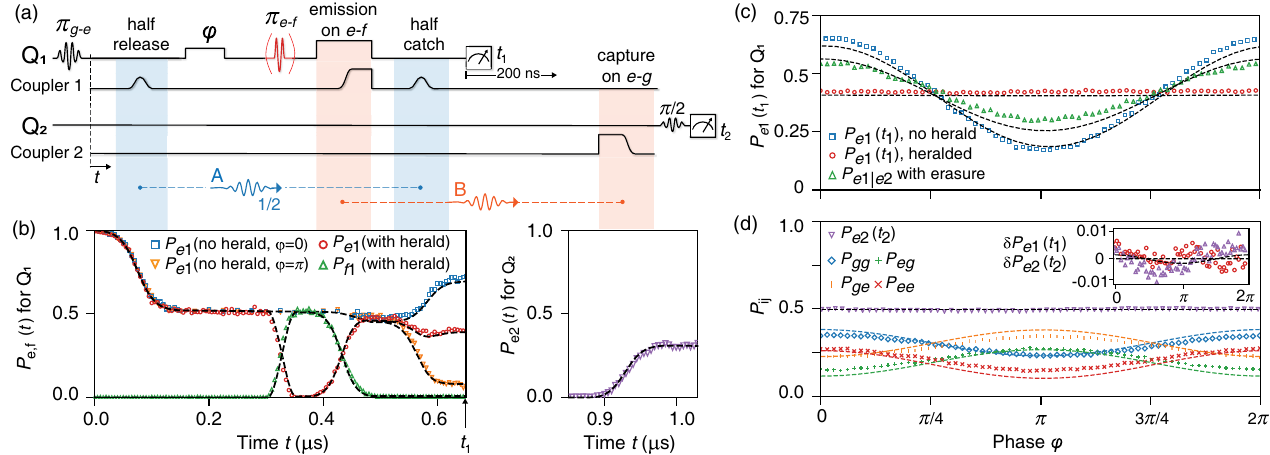
FIG. 4. Quantum eraser. (a) Pulse sequence: With Q 1 in j e i , its coupler is used to half-release a phonon at ω (blue). Q 1 ’ s frequency is A then detuned, accumulating a phase φ between the half-phonon and Q 1 ’ s j e i state. An optional π pulse on Q 1 ’ s e - f transition (red) is followed by the coupler-controlled emission of a phonon at ω (orange), heralding that Q 1 is in j e i and returning Q 1 to j e i . Following B the optional heralding, Q 1 catches the half-phonon (blue) and is measured, completing the interferometry. Following Q 1 ’ s measurement, Q 2 catches the optional heralding phonon (orange) and is measured at time t 2 ¼ 1 . 1 μ s. (b) Left: Q 1 ’ s j e i and j f i state populations as a ð t Þ for φ ¼ 0 and φ ¼ π , which at time t function of time t , showing the unheralded P 1 displays the interference maximum and e minimum, and for the heralded P , which at time t 1 does not have a φ dependence. Also shown is Q 1 ’ s j f i state population when the e ð t Þ when the herald is generated, which ideally would reach the value 1 = 2 but is limited herald is generated. Right: Q 2 ’ s excited state P e ð φ Þ are visible when the herald is absent, but disappear when the herald by acoustic losses to η × 0 . 5 ≈ 0 . 32 . (c) Interference fringes P b e reports which-path information ( Q 1 in j e i ). If the herald is generated but the information in Q 2 is erased, by applying a π = 2 pulse on Q 2 ’ s g - e transition, the fringes reappear when Q 1 ’ s measurement is conditioned on measuring Q 2 in j e i . This occurs even though Q 1 ’ s measurement was already complete by the time the information in Q 2 is erased. (d) Probability of measuring Q 2 in j e i , showing lack of dependence on φ . Also shown are variations in two-qubit probabilities P , P , P , and P . Inset shows the lack of variation of both gg ge eg ee qubits ’ j e i -state probabilities P and P as a function of φ when applying the π pulse. Dashed lines in all panels correspond to a e 1 e 2 ef numerical model taking into account the qubits ’ decoherence and phonon losses; see Ref.